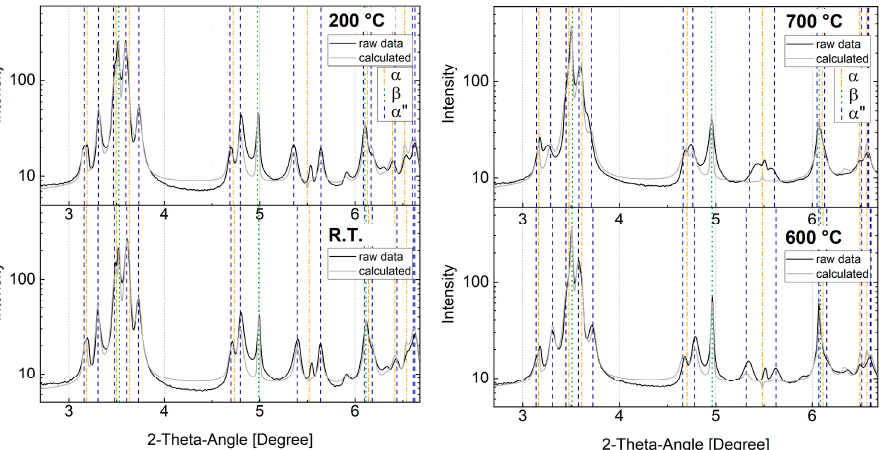
Figure 9. Examples of in situ diffractograms (raw data) vs. calculated diffraction lines with sequential Rietveld refinement at temperatures of 30 (R.T.), 200, 600 and 700 °C. With the logarithmic representation, the local deviations were intentionally exaggerated for illustration purposes. The graphs highlight the superposition of diffractions lines of the α -phase and α″ -martensite as well as the β -phase (with the exception of the β -diffraction line at ~5°). They further show the challenges concerning the exact approximation of the peak intensities caused by grain coarsening. The gradual degradation of α″ -martensite into α -Ti (see diffractograms at 600 °C and 700 °C) ultimately triggers the misinterpretation of the α″ → α transformation rates.